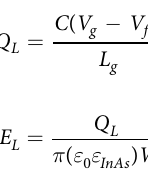
two-dimensional FETs fabricated from III-V material 7, 8 .